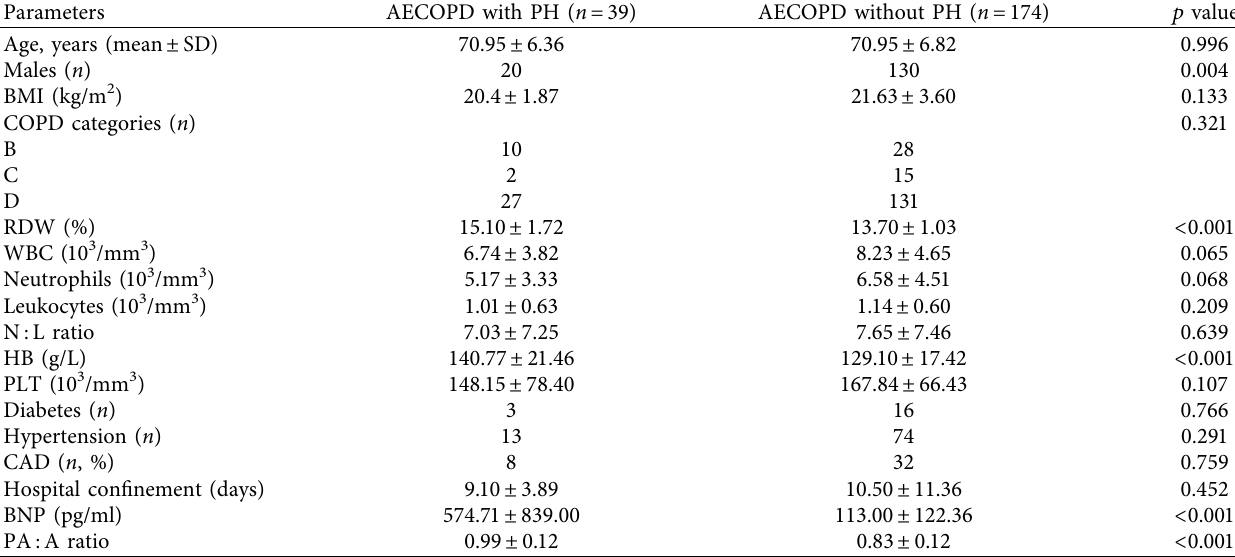
Table 1: Baseline characters of demographic, clinical, laboratory tests, and CT.